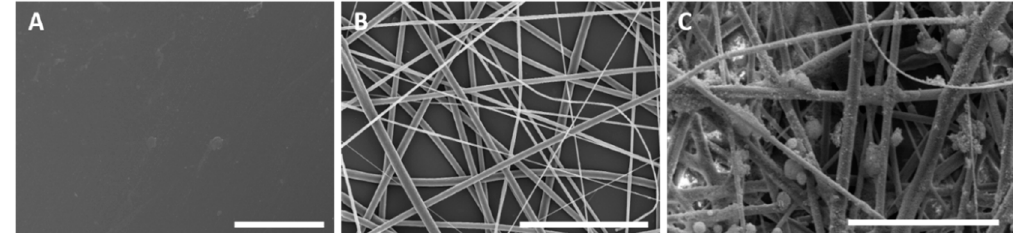
Figure 2. ( A ) Field emission scanning electron microscopy (FESEM) images of the as-received polyethylene terephthalate (PET) film; ( B ) Electrospun polylactide (PLA) fibers deposited onto the PET film; ( C ) Electrosprayed silica (SiO 2 ) microparticles onto the PET/PLA fibers. Scale bars of 50 µm.